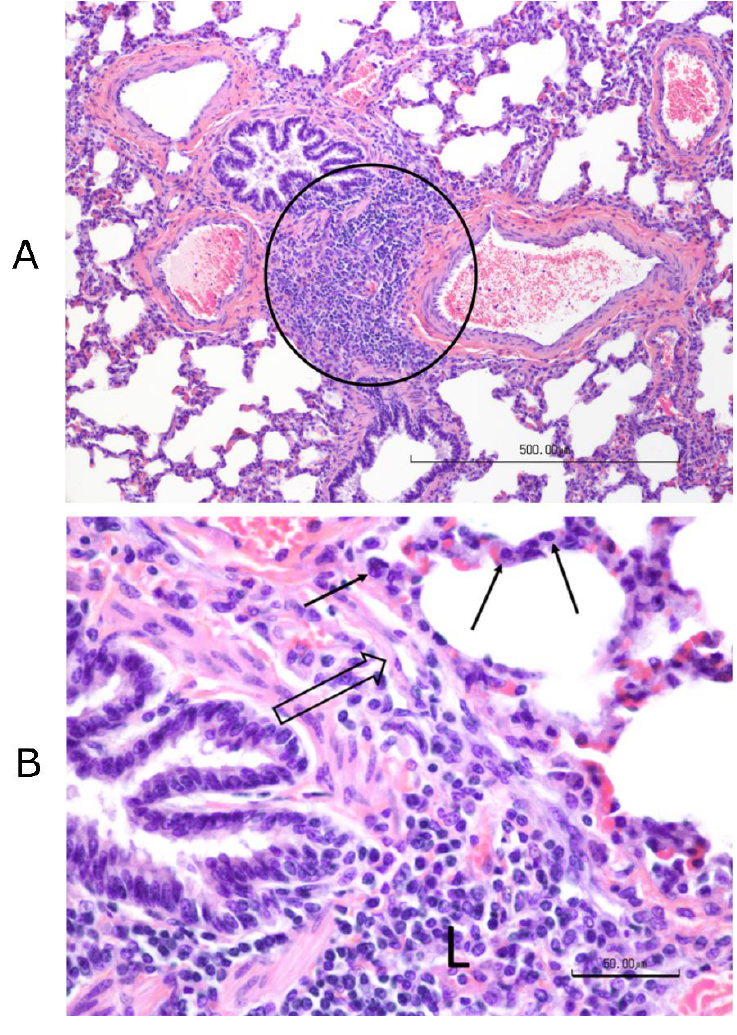
Figure 13. ( A ) Commercial “Bovi” vaccine group: Notice the marked increase in BALT: bronchus– associated lymphoid tissues (encircled). The bronchiole is constricted, which is not considered a significant lesion. Alveolar spaces are clear. Bar = 500 µM. ( B ) “Bovi” vaccine group: Marked increase in BALT (L). Mild fibrosis is evident (open arrow). A few mononuclear inflammatory cells have infiltrated the adjacent alveolar septa (solid arrows). Bar = 50 µM.